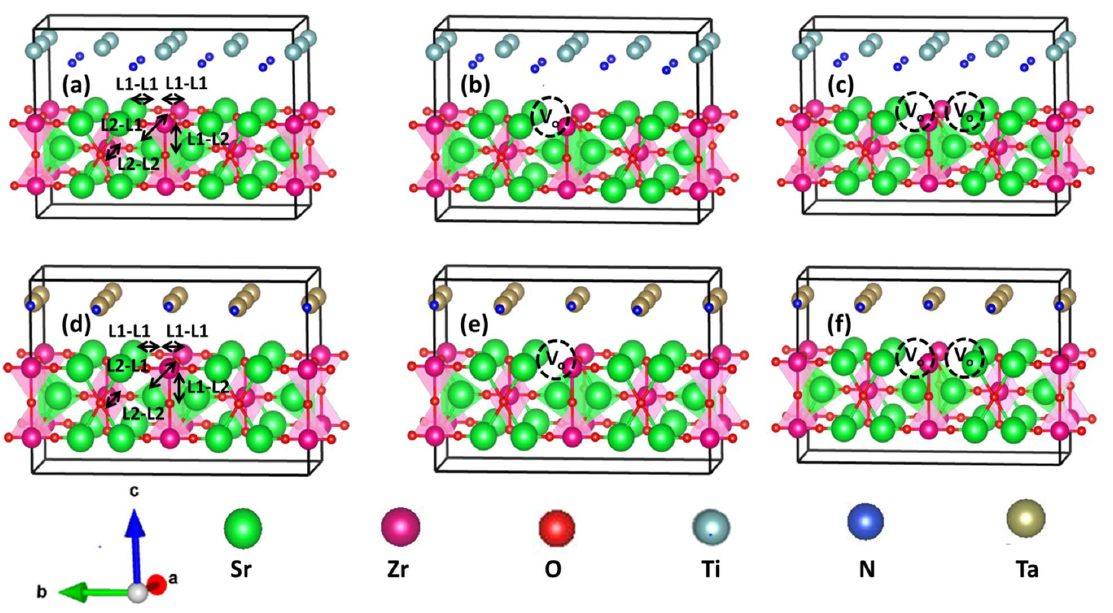
Figure 1. Three dimensional view of considered layer Ruddleson–Popper perovskite attached with electrode composite ( a ) pristine Sr 2 ZrO 4 /TiN, ( b ) Sr 2 ZrO 4 + 1V o /TiN, ( c ) Sr 2 ZrO 4 + 2V o /TiN, ( d ) Sr 2 ZrO 4 /TaN, ( e ) Sr 2 ZrO 4 + 1V o /TaN and ( f ) Sr 2 ZrO 4 + 2V o /TaN, respectively. Here c axis is used to stack the layers of the studied composites. Pink and green highlighted regions are indicative of octahedral and tetrahedral bonding of Zr-O and Sr-O. Table 2. Bond length of the Sr 2 ZrO 4 /TiN and Sr 2 ZrO 4 /TaN.